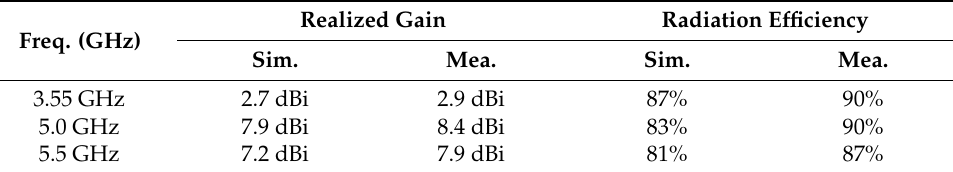
Table 1. Realized gain and radiation efficiency.